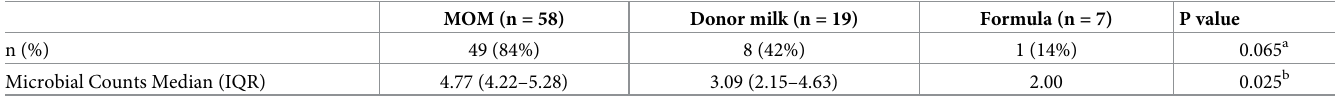
Table 4. S . epidermidis isolated from the feeding samples after their pass through the enteral feeding tubes. Counts expressed as log 10 CFU/g.